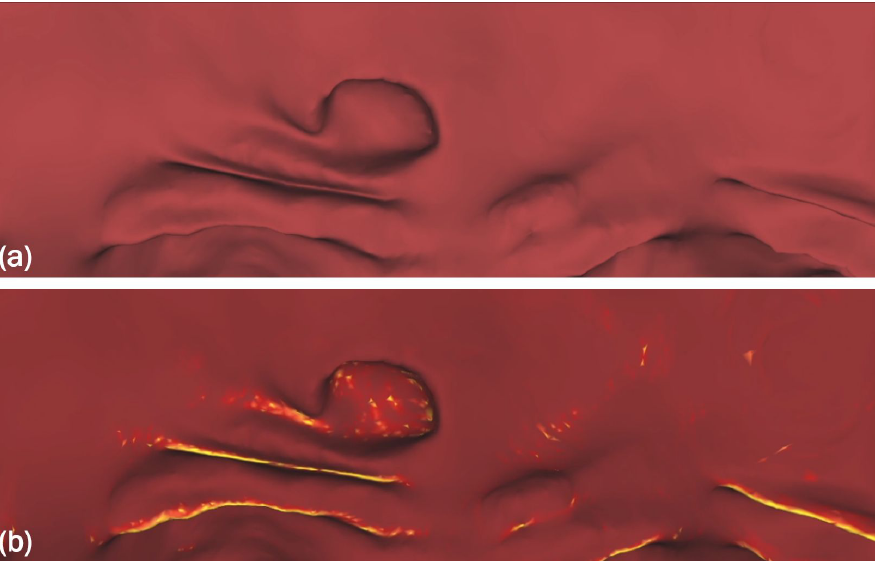
Figure 5. ( a ) An RGB image captured by virtual cameras. ( b ) Adding curvature information to the image highlights the convex and concave